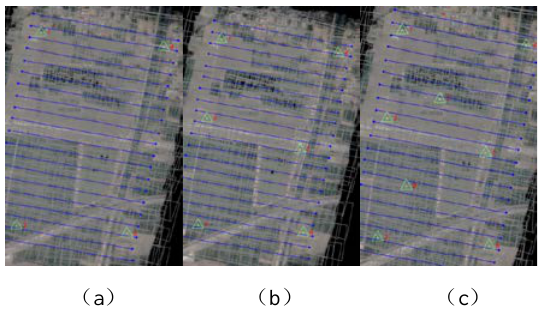
Figure 6. Number distribution map of different image control points in the same survey area